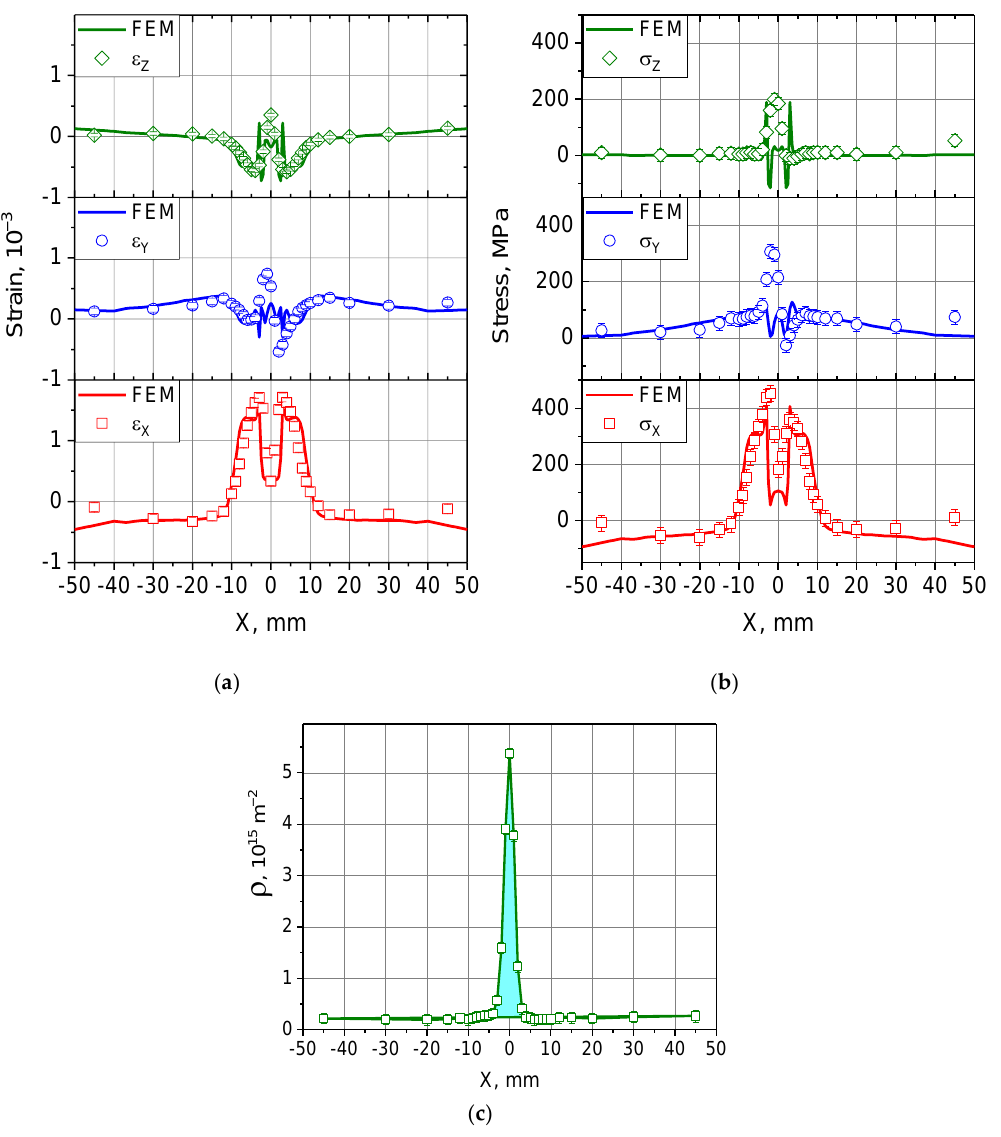
Figure 15. Residual strain ( a ) and stress ( b ) measured by neutron diffraction and FEM calculations for thin steel plate sample with a laser beam welded (LBW) joint. ( c ) Dislocation density distribution estimated from diffraction peak broadening in the LBW sample, adapted from [36], with permission from © 2017 SPIE.